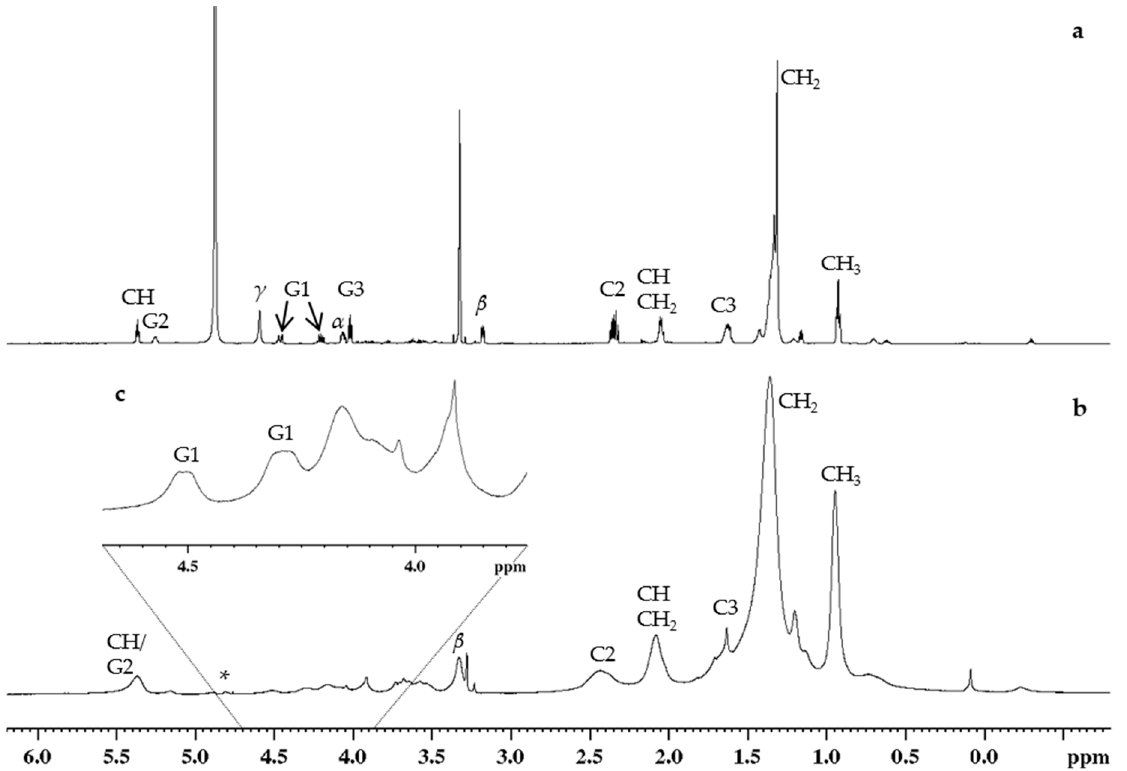
Figure 2. 1 H NMR spectra of the E . coli lipid extract with assigned proton signals at 25 °C: ( a ) measured in MeOD- d 4 with 600 MHz, ( b ) measured in D 2 O with 400 MHz HR-MAS probe along with ( c ) a highlighted ppm range of 3.7–4.7. Example structures of the lipids with labels are presented in Figure 5. * Possible distortion in the HR-MAS spectra caused by water presaturation masks some signals detected in the 600 MHz spectra.